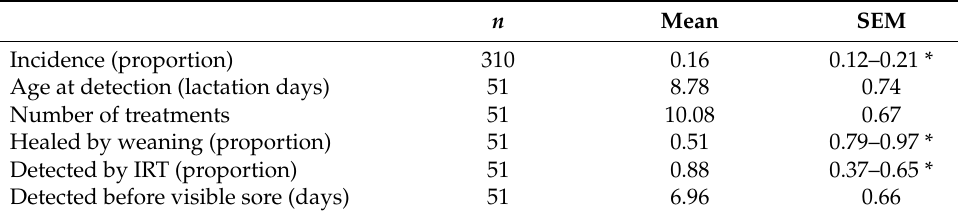
Table 2. Mean ± SEM values for timing, occurrence, detection, and healing of shoulder sores.